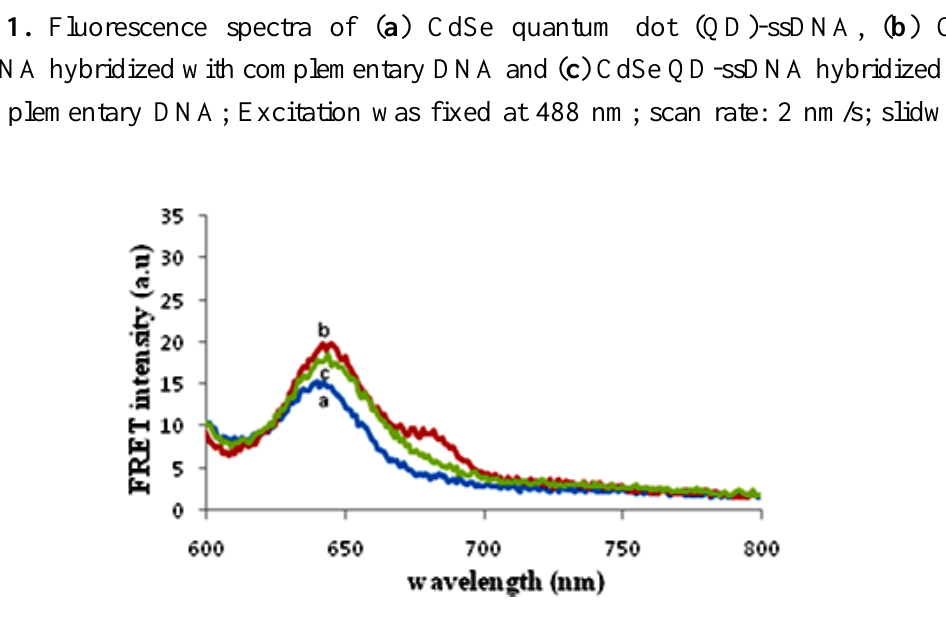
Figure 2. Fluorescence resonance energy transfer between donor QD and acceptor